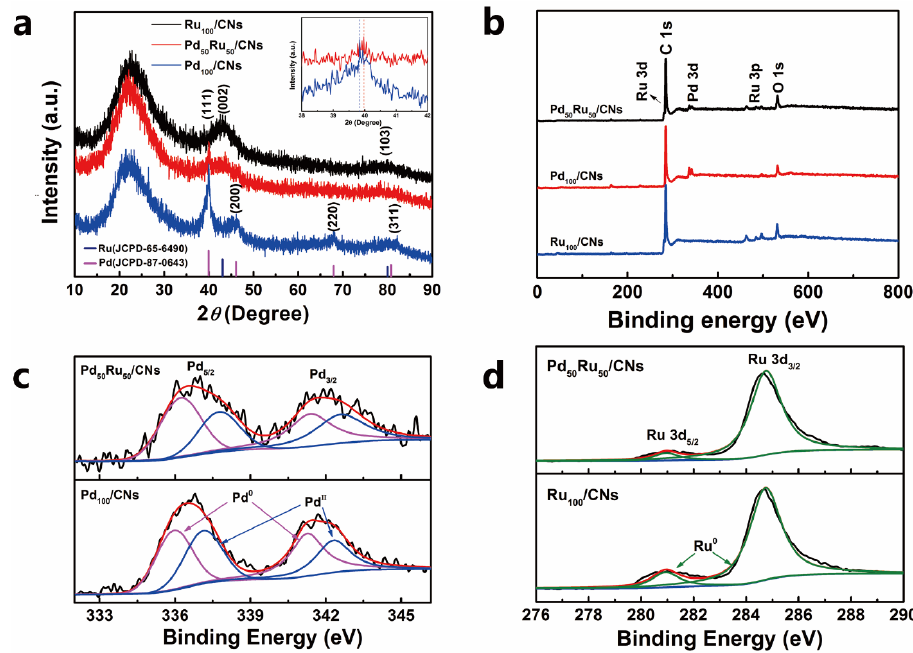
Figure 2. ( a ) The XRD patterns and ( b ) XPS survey scan spectra of the Pd 50 Ru 50 /CNs, Pd 100 /CNs, and Ru 100 /CNs; the core-level XPS spectra of ( c ) the Pd3d electrons for the Pd 50 Ru 50 /CNs and Pd 100 /CNs; and (d) the Ru3d electrons for the Pd 50 Ru 50 /CNs and Ru 100